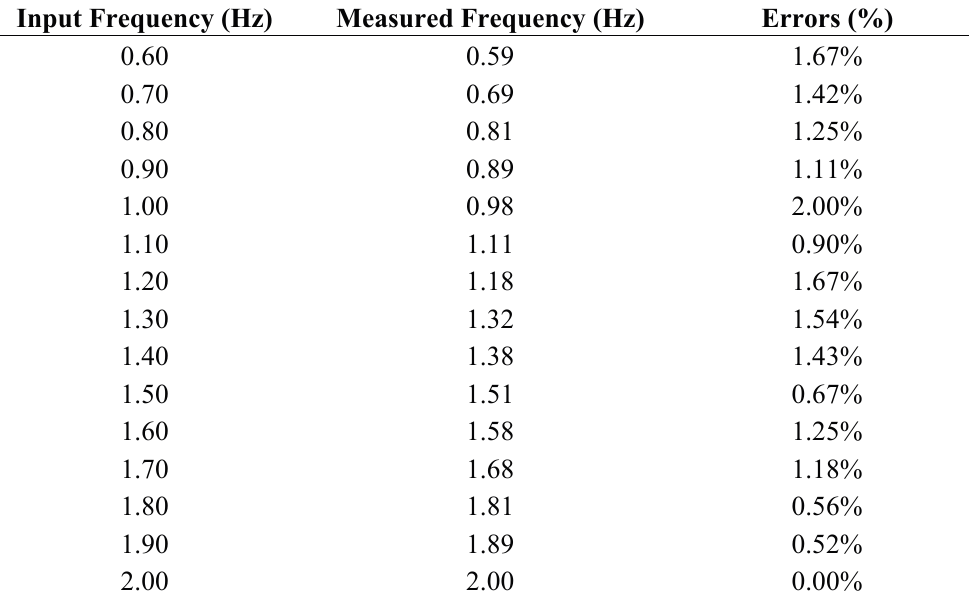
Table 1. Results of frequency precision